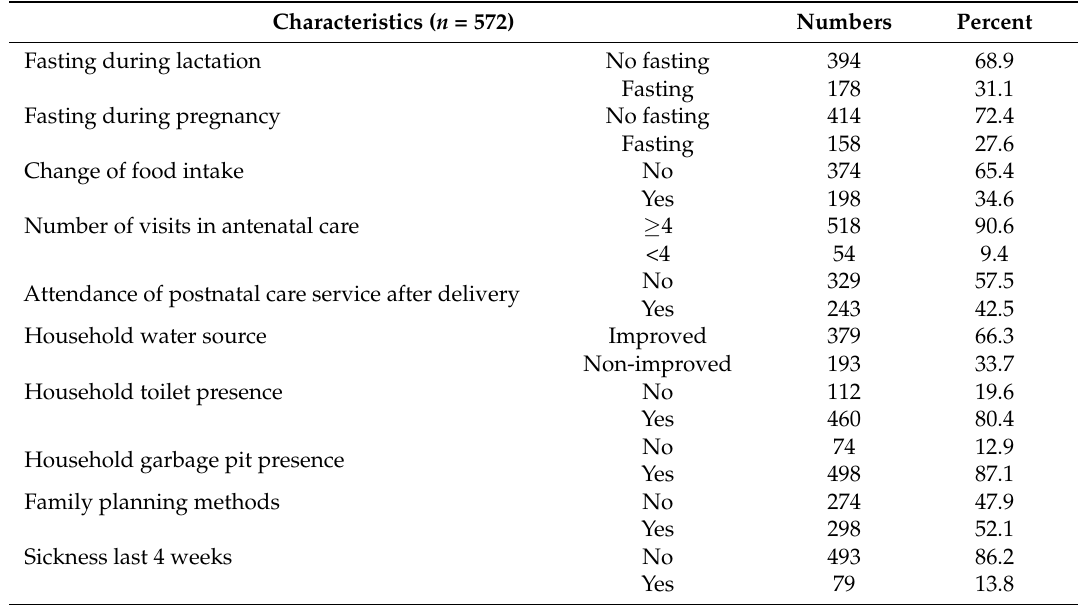
Table 2. Maternal health and feeding practices ( n = 572) in rural Tigray, Northern Ethiopia (February–June